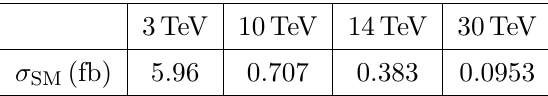
Table 2 . The results of σ SM for µ + µ − → γγγ after the basic cuts in eq.